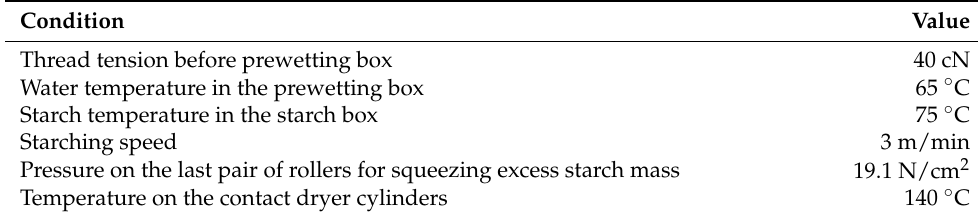
Table 4. Conditions during the starching process. Condition Value Thread tension before prewetting